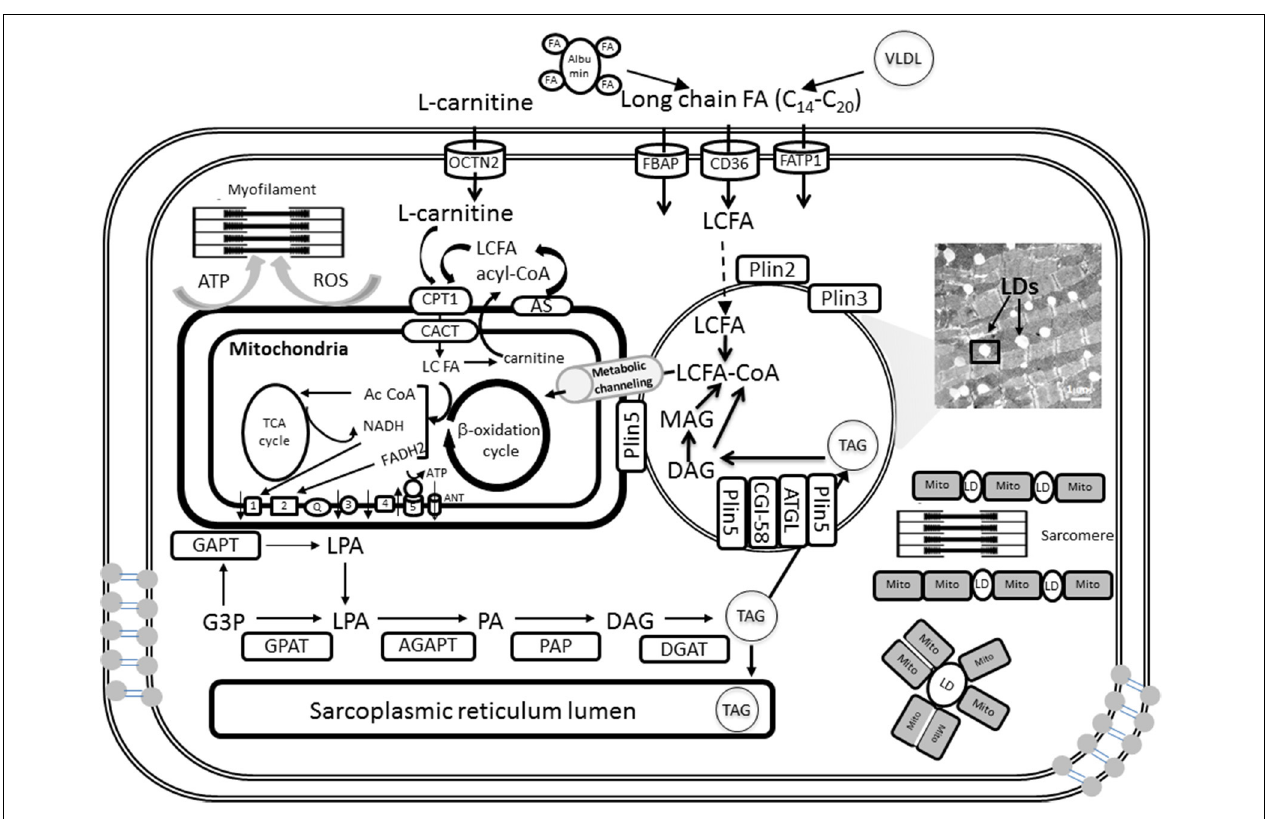
FIGURE 1 | Triglyceride synthesis, storage in lipid droplets, and FA oxidation in cardiomyocyte mitochondria. A detailed explanation of the processes depicted in this figure will be found in sections Lipid Droplets and TAG Metabolism and Fatty Acids and Mitochondrial Function of the main text. LDs can be intercalated with mitochondria or surrounded by them as shown schematically at the right bottom. When mitochondria and LD interact in